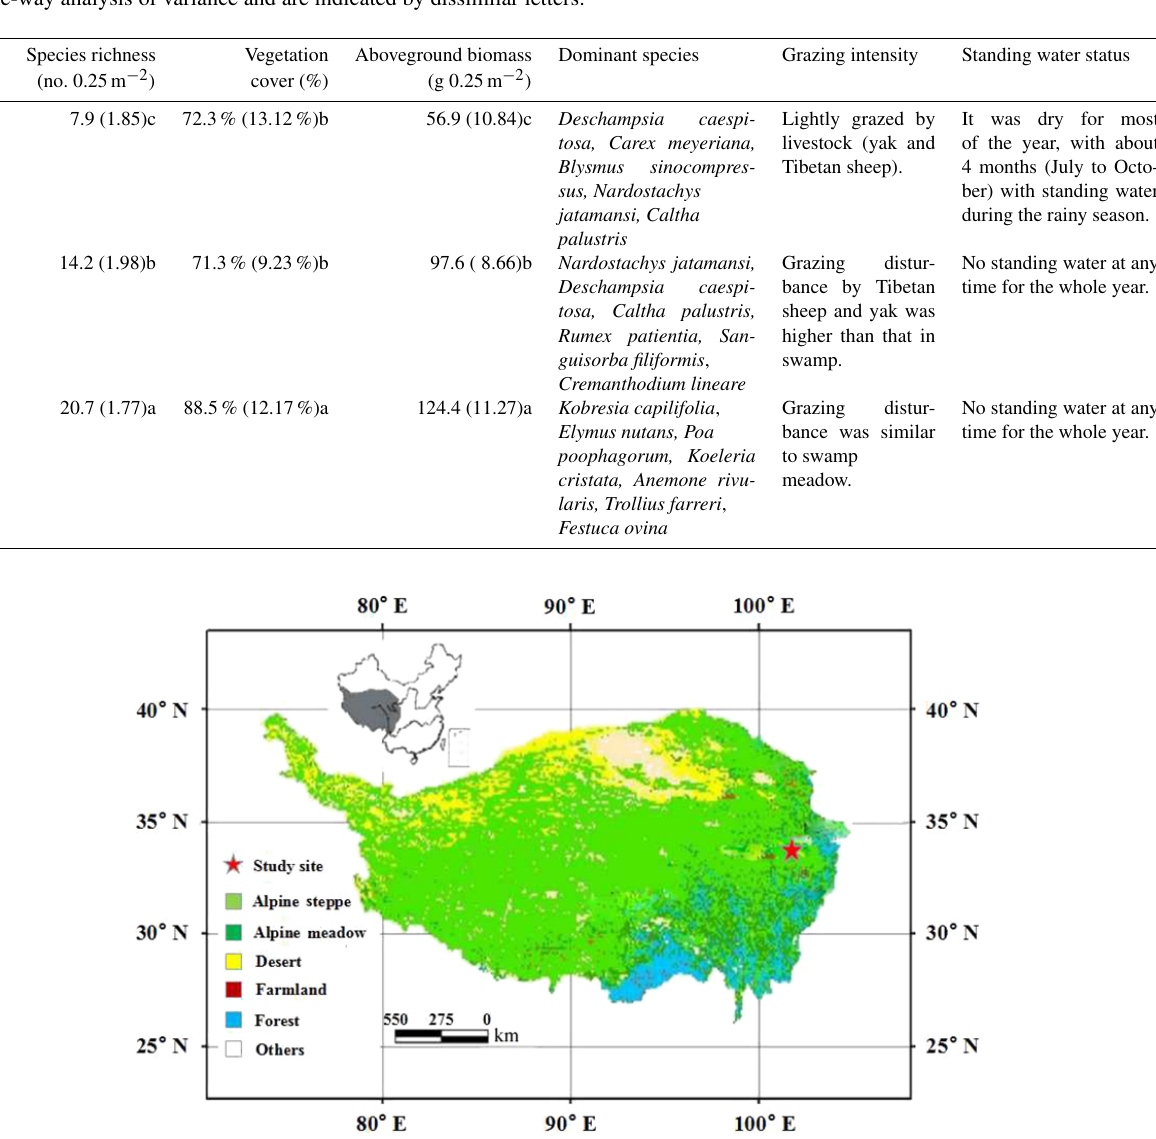
Table 1. Brief descriptions for vegetation properties (species richness, vegetation cover, aboveground biomass, and dominant species), grazing intensity, and standing water status during the wetland drying. Swamp is S, swamp meadow is SM, and typical meadow is TM. Significant differences across treatments within each variable were determined using Tukey’s honest significant difference test ( P <0.05) after one-way analysis of variance and are indicated by dissimilar letters.